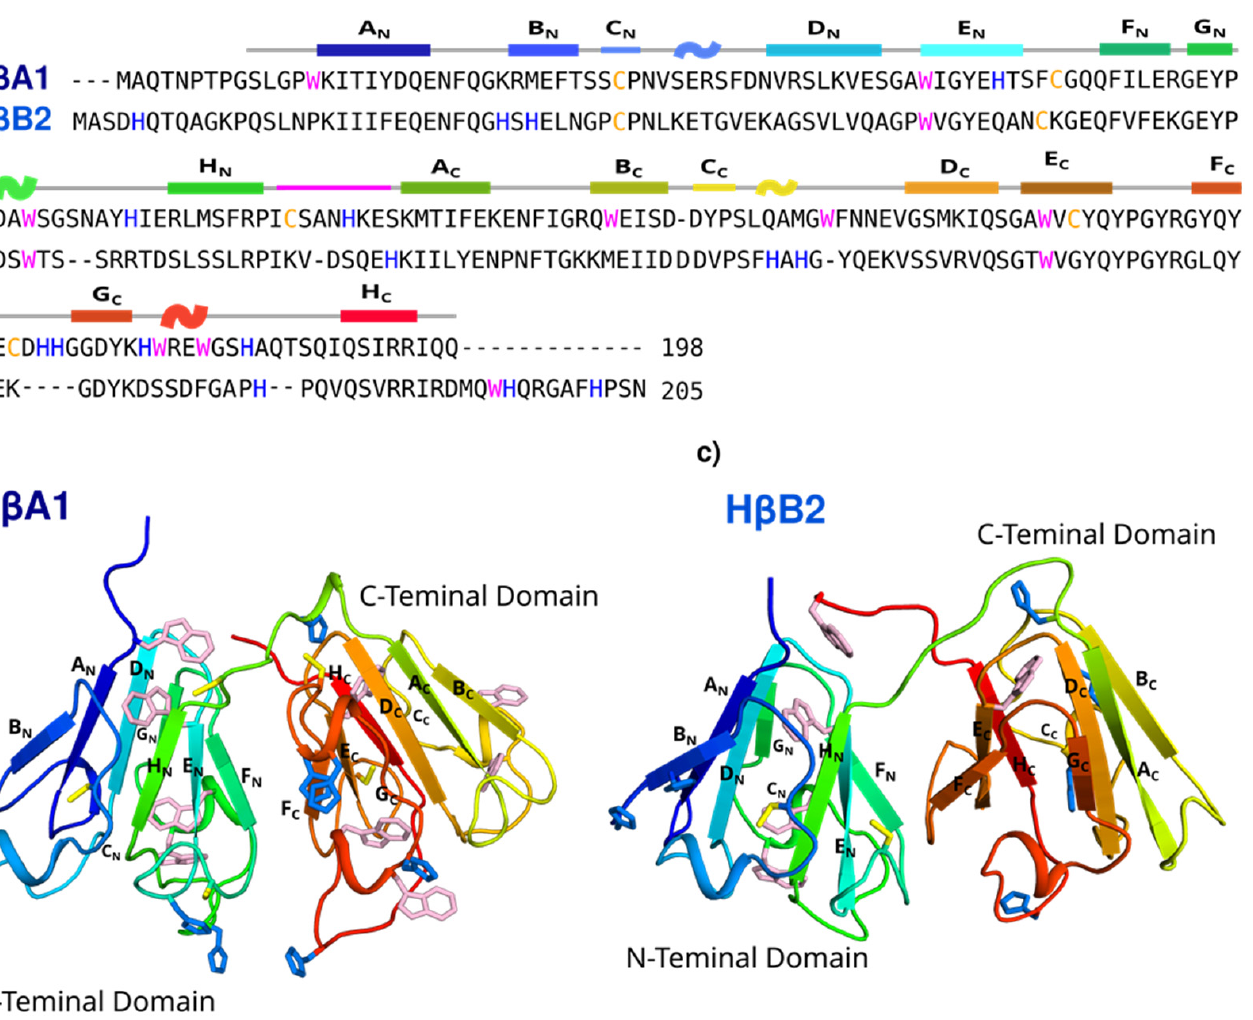
Figure 1. β -crystallin structures and sequences. ( a ) Sequence alignment of H β A1 and H β B2 crys- tallins. The elements of the secondary structure of the N-terminal and C-terminal domains and the linker region are shown. Histidine residues are shown in blue, cysteines in yellow, and tryptophan in magenta. Three-dimensional structure models of ( b ) H β A1 and ( c ) H β B2. Each strand is named A through H for each domain.